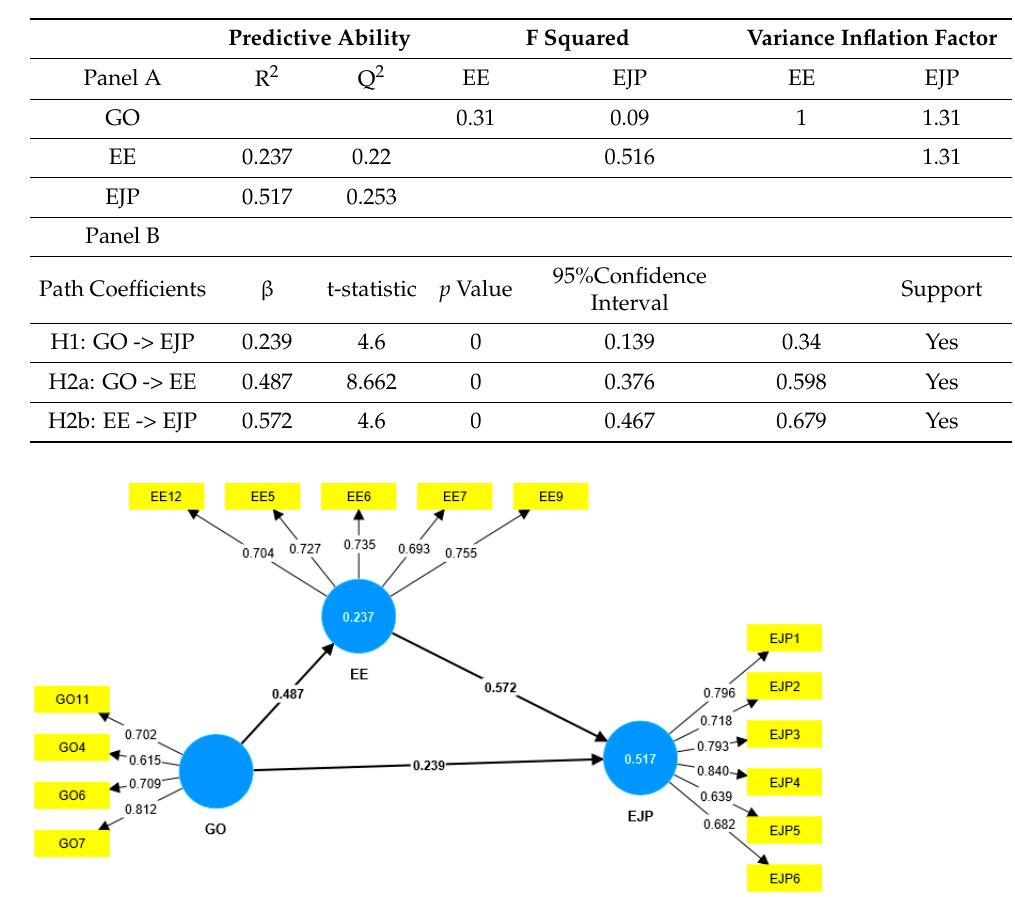
Table 5. Structural Model Results.